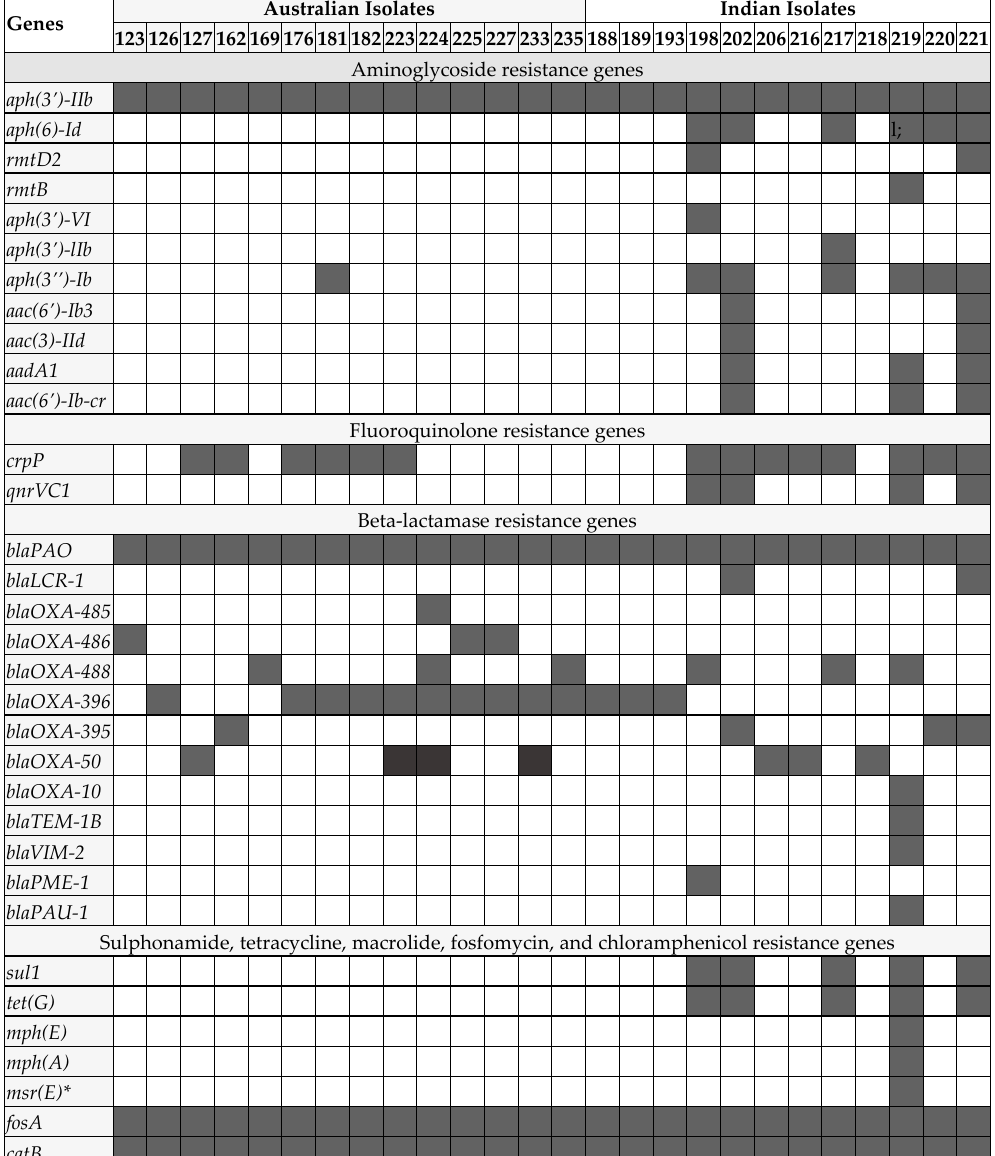
* msr(E) encodes macrolide and lincosamide resistance . Isolates shaded in grey indicate Australian strains. Black color represents gene presence .